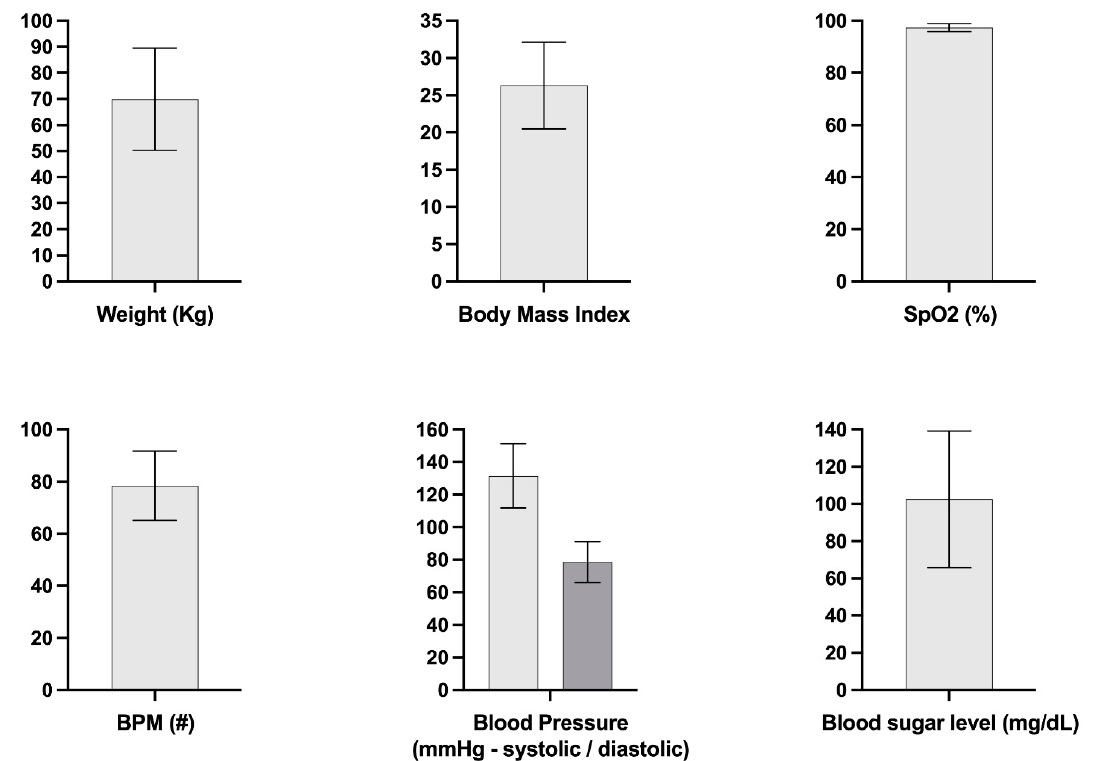
Figure 1. Main health parameters evaluated in our sample.